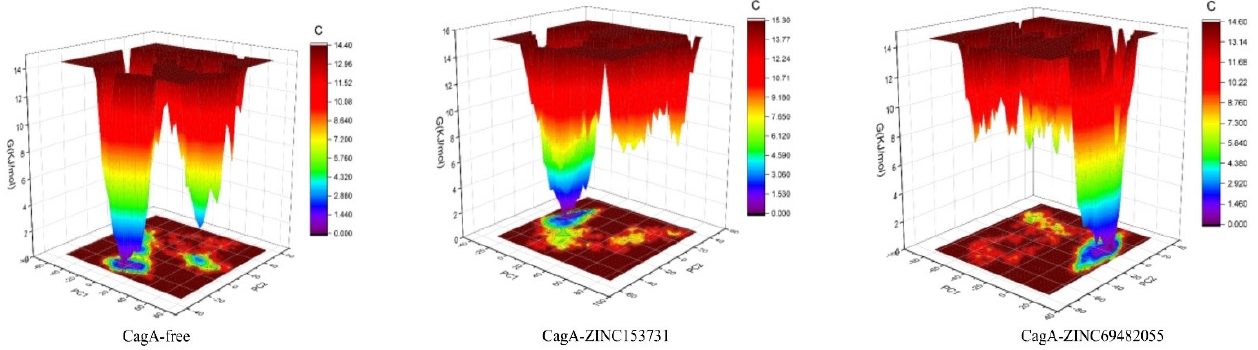
Figure 9. GFE landscape of complexes.